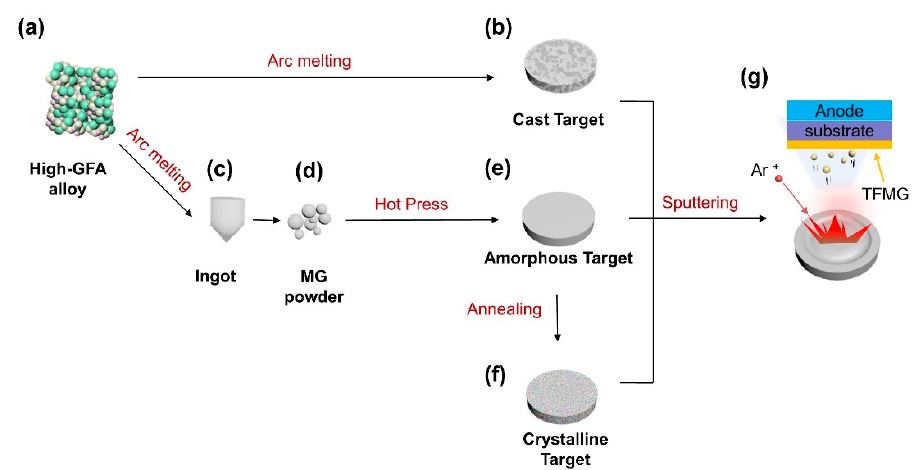
Figure 1. Schematic of target manufacture. ( a ) Preparation of alloy compositions with high glass-forming ability. ( b ) Manufacture of cast targets via arc melting method. ( c ) Manufacture of ingots via arc melting method. ( d ) Metallic glass powder preparation using an atomizer. ( e ) Use of spark plasma